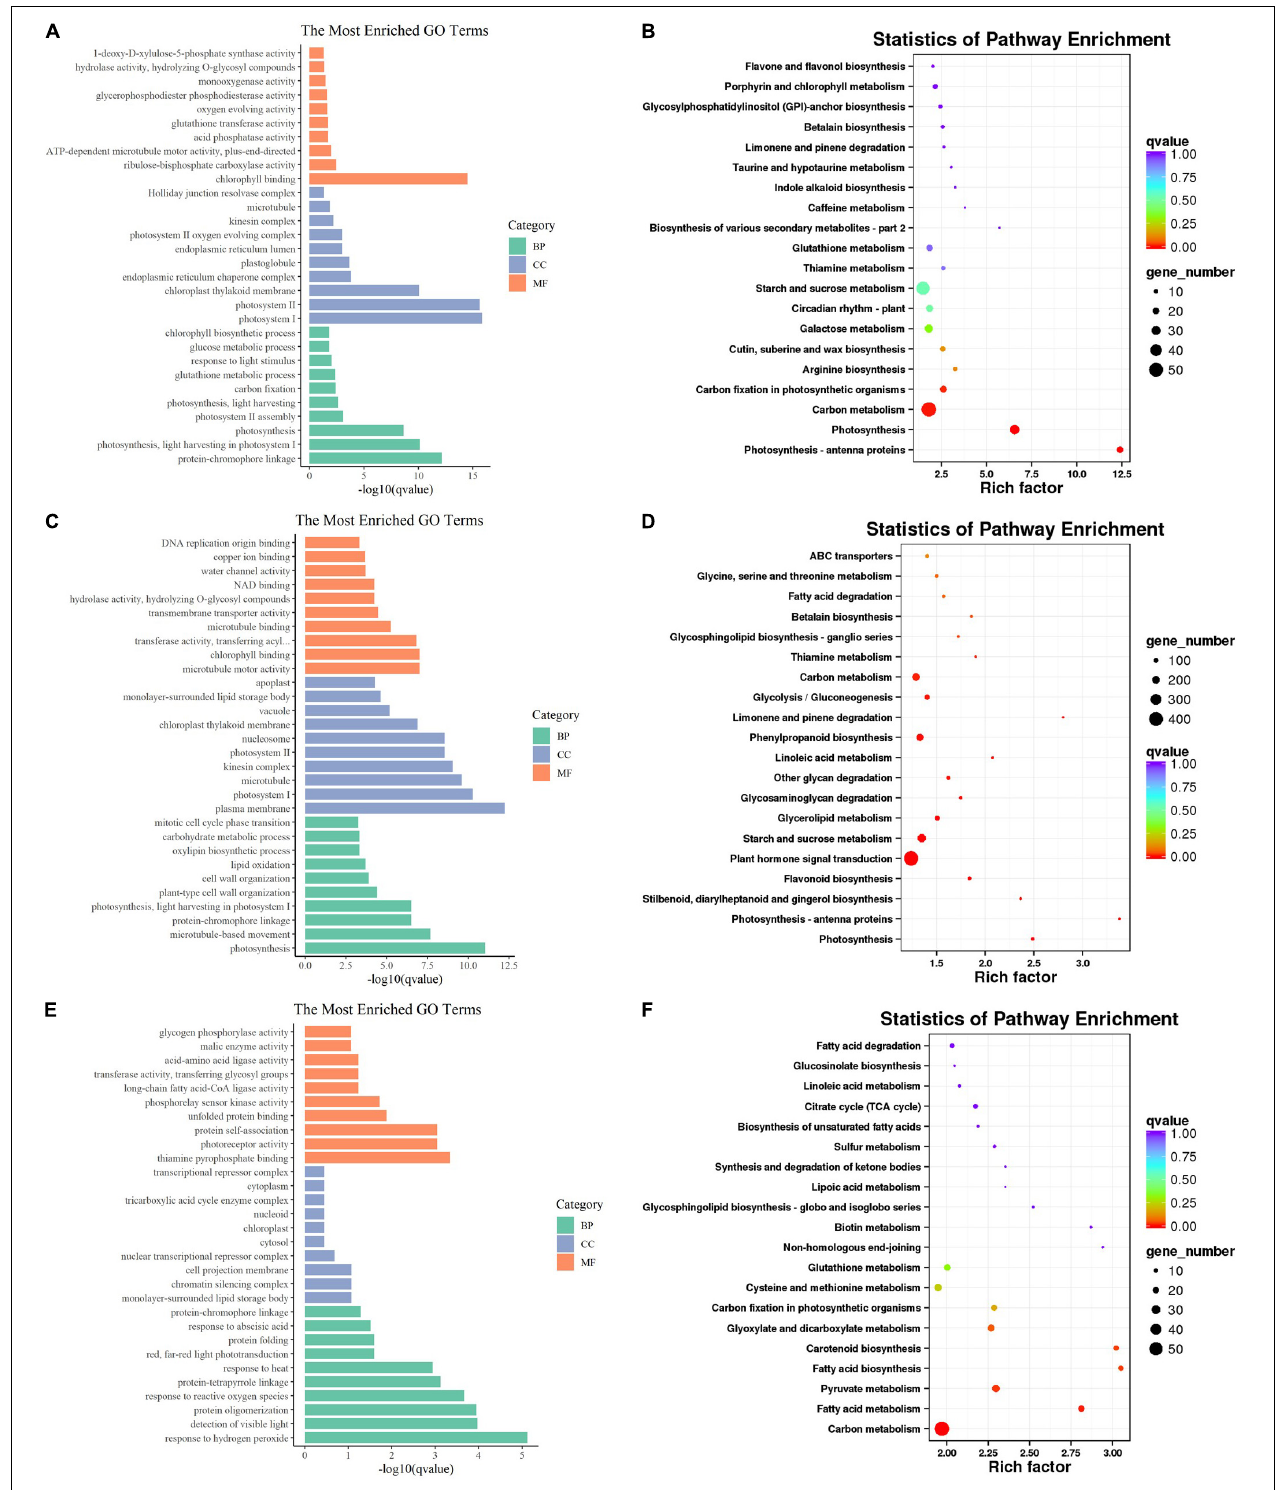
FIGURE 3 | Gene Ontology and KEGG enrichment analysis of DEGs. The most enriched GO terms of DAF 30 (A) , DAF40 (C) and DAF 50 (E) . Top 20 KEGG pathways of DAF 30 (B) , DAF 40 (D) and DAF50 (F) .